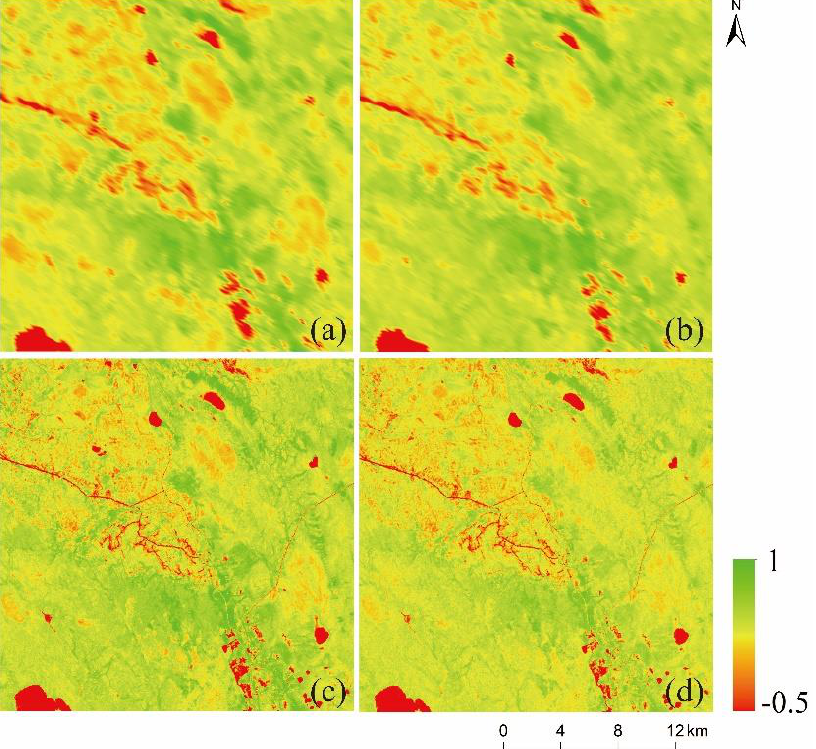
Figure 2. Testing datasets of forest areas. ( a , b ). MODIS_NDVI on 11 July and 12 August 2001; ( c , d ). Landsat_NDVI on 11 July and 12 August 2001.